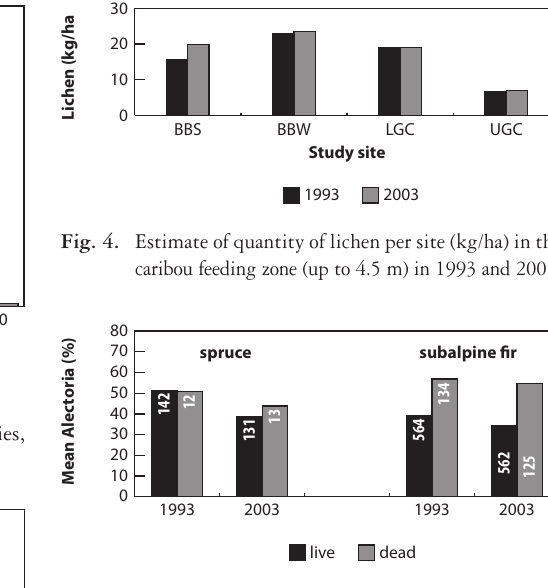
Fig. 5. Composition of lichen (average percentage of Alectoria ) on dead and live subalpine fir and spruce trees in 1993 and 2003 for trees rated class 2 and higher. Sample size (number of trees) is noted in each bar.